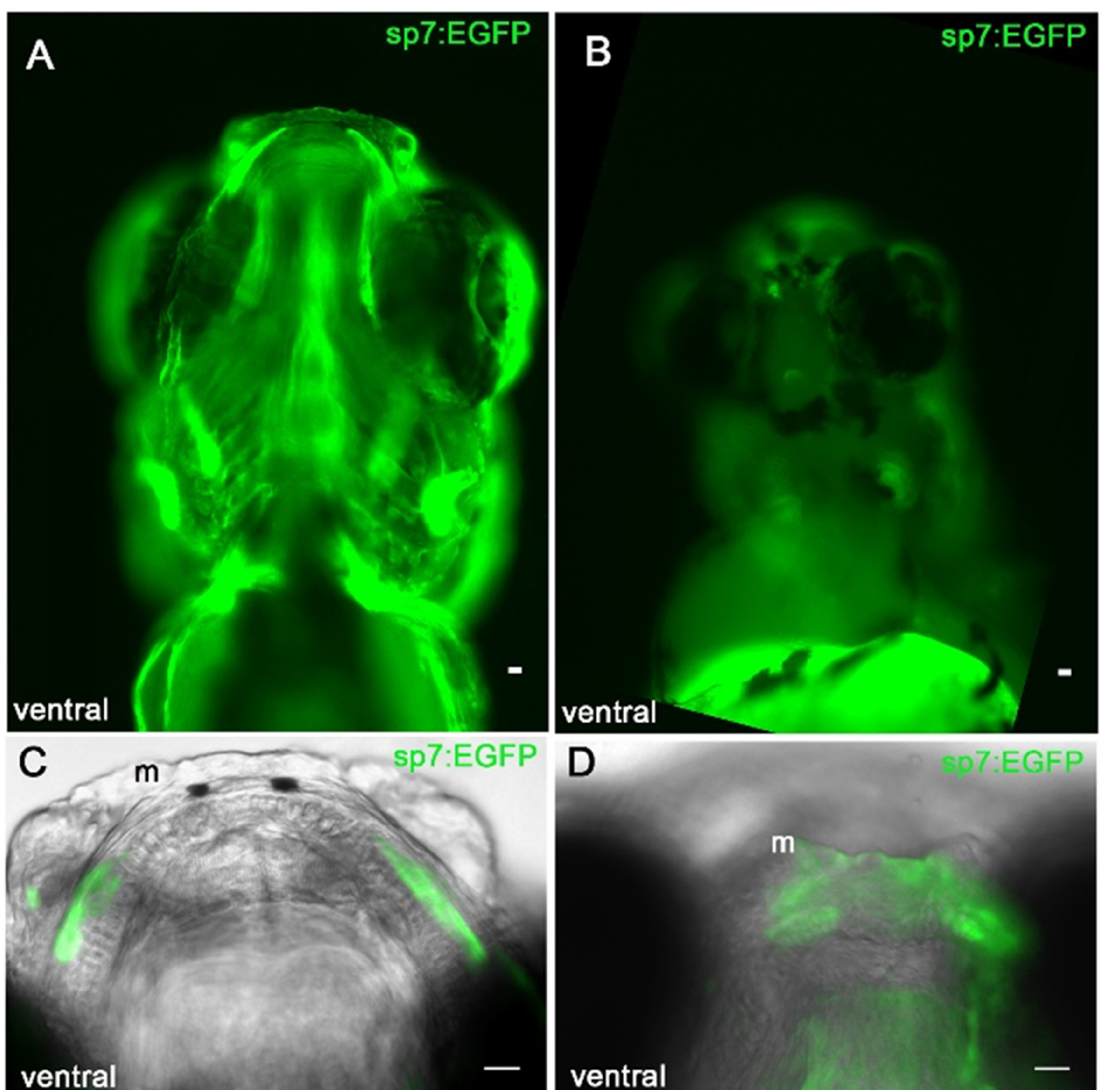
Figure 4. Col11a1a knockdown disrupts the organization of bone forming cells that line the Meckel’s cartilage. Ventral view of sp7:EGFP positive cells in 5 dpf control zebrafish ( A , C ) and morphant ( B , D ). sp7:EGFP expressing cells line the cartilage template in the control zebrafish ( C ). sp7:EGFP expressing cells form small condensations at the mediolateral cartilage but fail to occupy the location of future mineralization immediately adjacent to the Meckel’s cartilage as observed in controls ( D ); Scale bar 20 μ m.